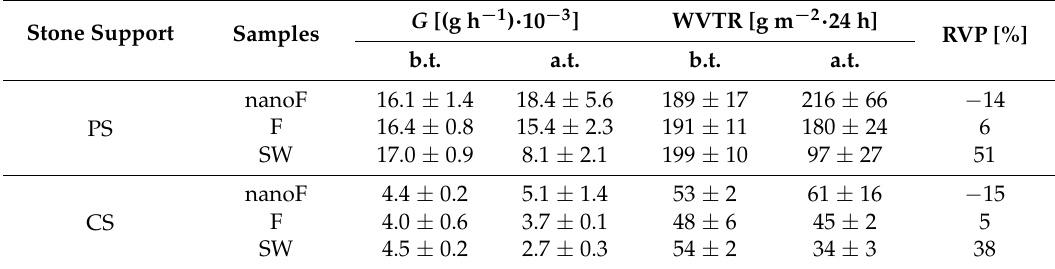
Table 5. Water vapor flow rate ( G ), water vapor transmission rate (WVTR), both before (b.t.) and after (a.t.) the treatment, and reduction of vapor permeability (RVP). Standard deviations are reported for each data set.